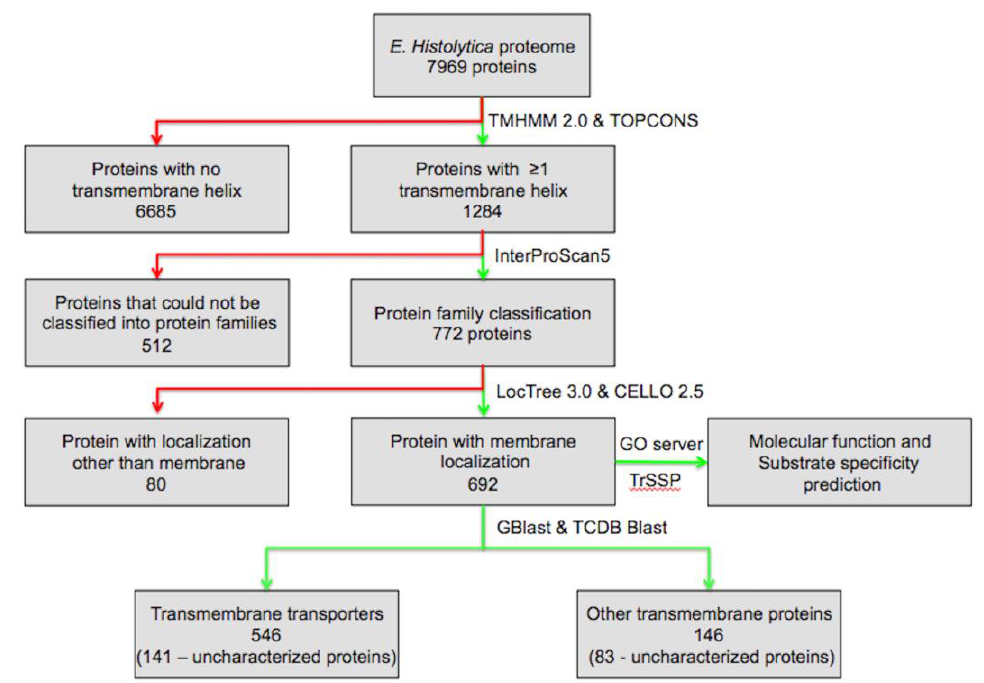
Figure 1. Flow scheme for the identification and classification of transmembrane (TM) proteins and TM transporters in Entamoeba histolytica . Green lines represent subsets of proteins that are included for further analysis, while red lines represent protein subsets that are excluded from further analysis.